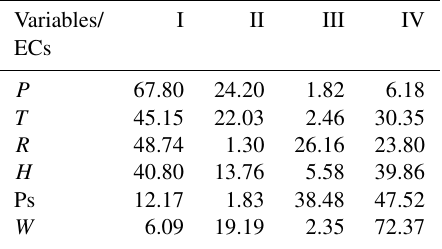
Table 5. Percent of land area (%) under each of the four effect cat- egories